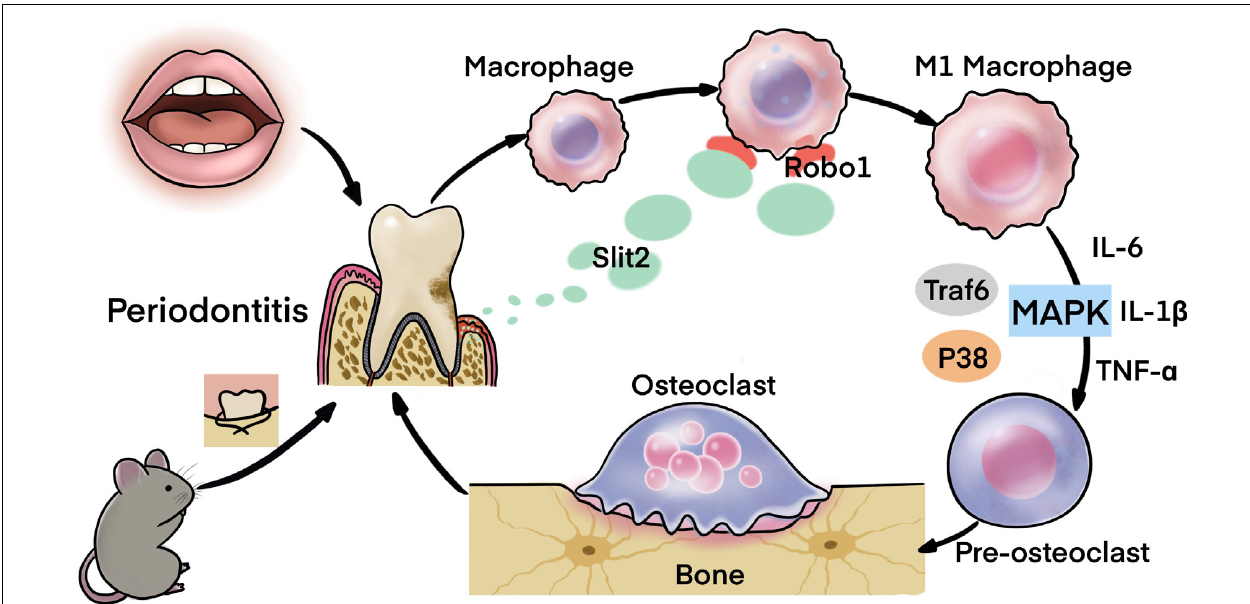
FIGURE 8 | Scheme showing the role of SLIT2 overexpression in pathophysiology of